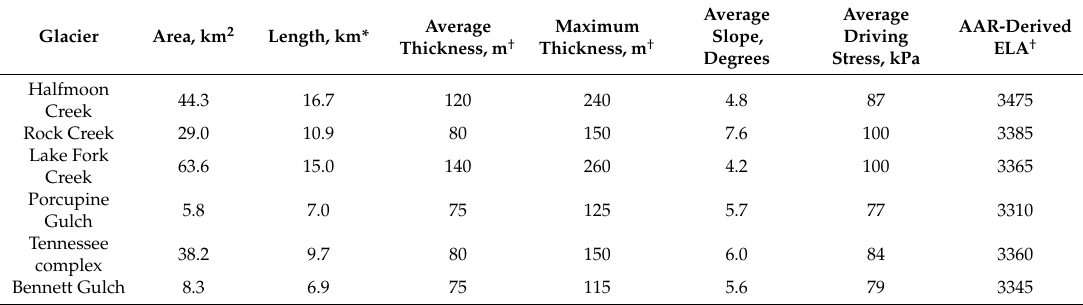
Table 2. Surface areas, lengths, thicknesses, mean slope of ice surfaces, mean driving stresses, and equilibrium-line altitudes (ELAs) of reconstructed